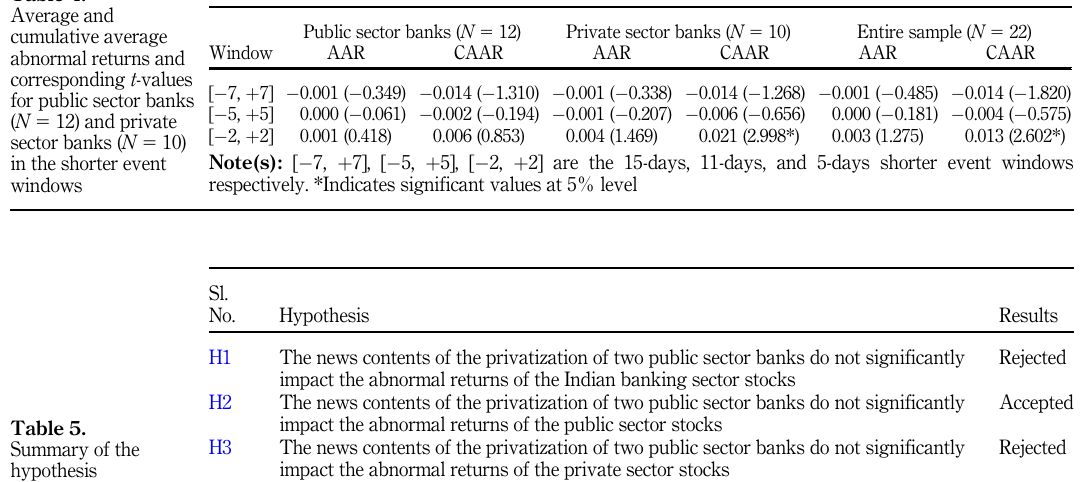
Table 5. Summary of the